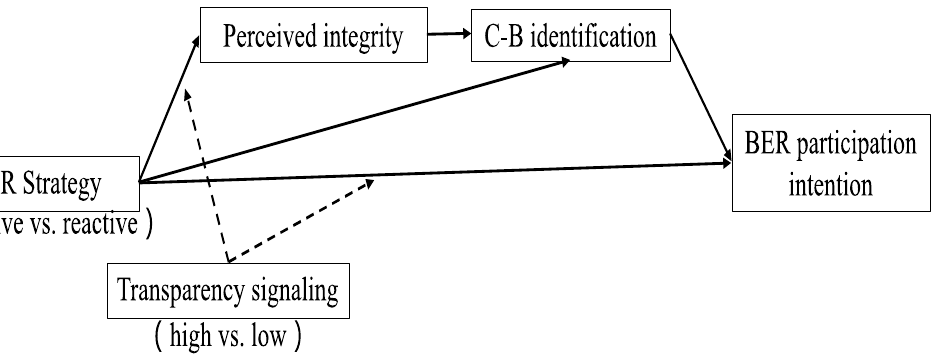
Figure 2. The “CSR strategy × Transparency signaling → perceived intergrity → CBI → BER participa- tion intention” moderated serial mediation.